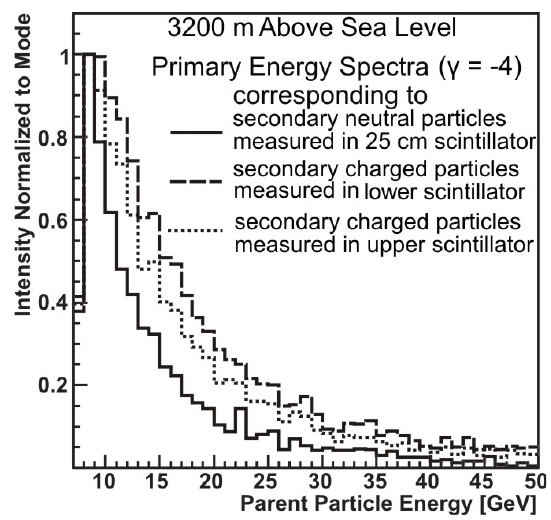
Fig. 8. Four-layer basic unit of the SEVAN.